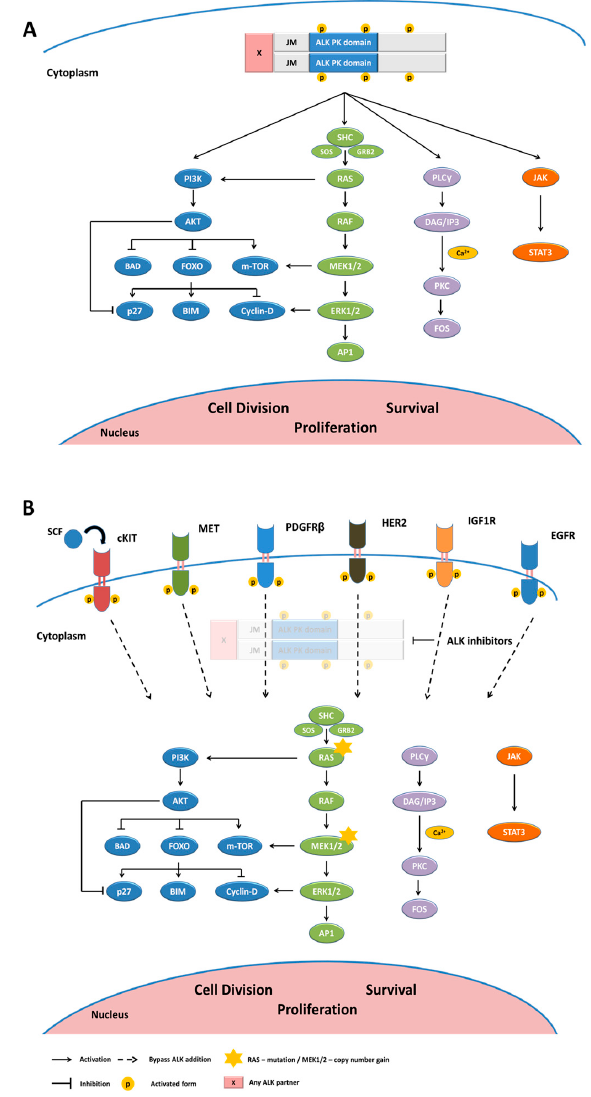
Figure 1. ALK downstream pathways and bypass signaling ( A ) Anaplastic lymphoma kinase (ALK) mediates signaling via the PI3K/AKT, RAS/MAPK, phospholipase C γ (PLC γ ) and Janus kinase (JAK)-signal transducer and activator of transcription (STAT); ( B ) ALK-independent resistance mechanism. Activation of bypass signaling pathways when ALK is inhibited with TKIs: EGFR activation, without EGFR mutations or amplifications; HER2 activation; c-KIT gene amplification in the presence of stem cell factor (SCF); MET activation bypassing ALK inhibitors without anti-MET activity; regulation via transcriptional of PDGFR β and IGFR activation. Mutations in KRAS and copy number gain of wild-type KRAS; JM, Juxtamembrane.